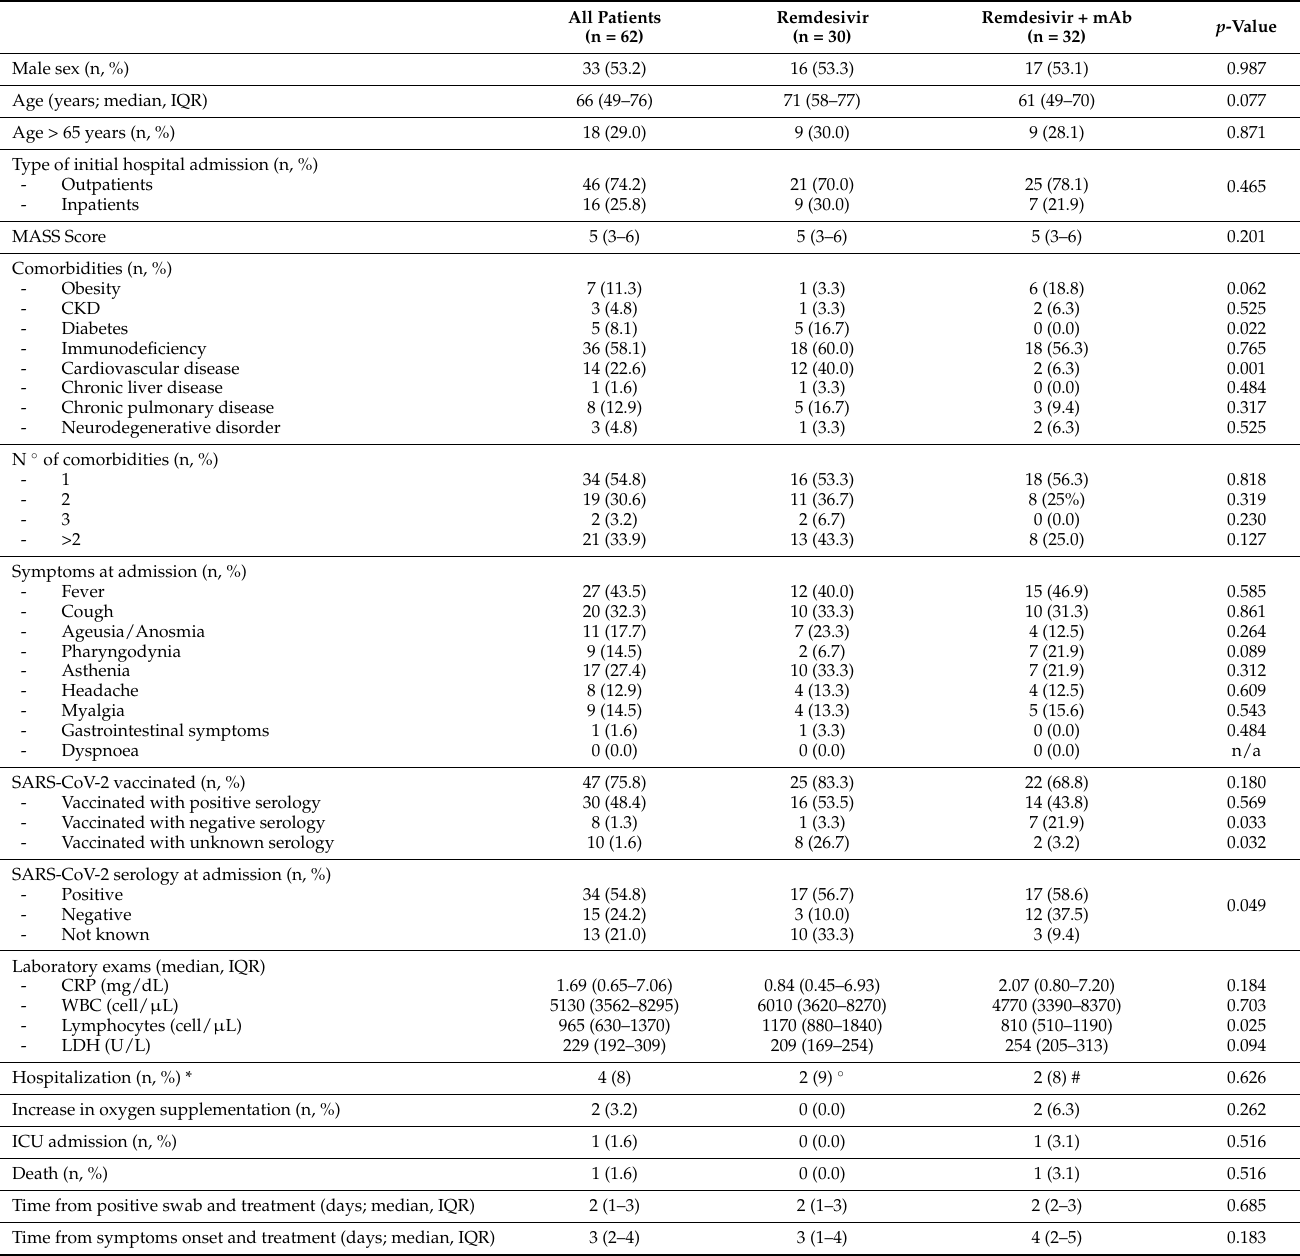
Table 1. Clinical characteristics of patients enrolled and differences between the two treatment